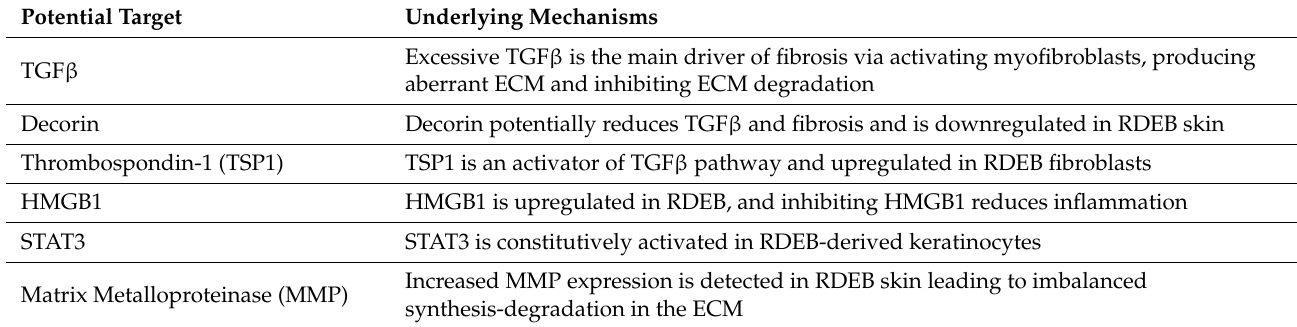
Table 1. Potential targets for therapy in RDEB. A brief summary of the key players involved in RDEB pathology and their mechanisms of